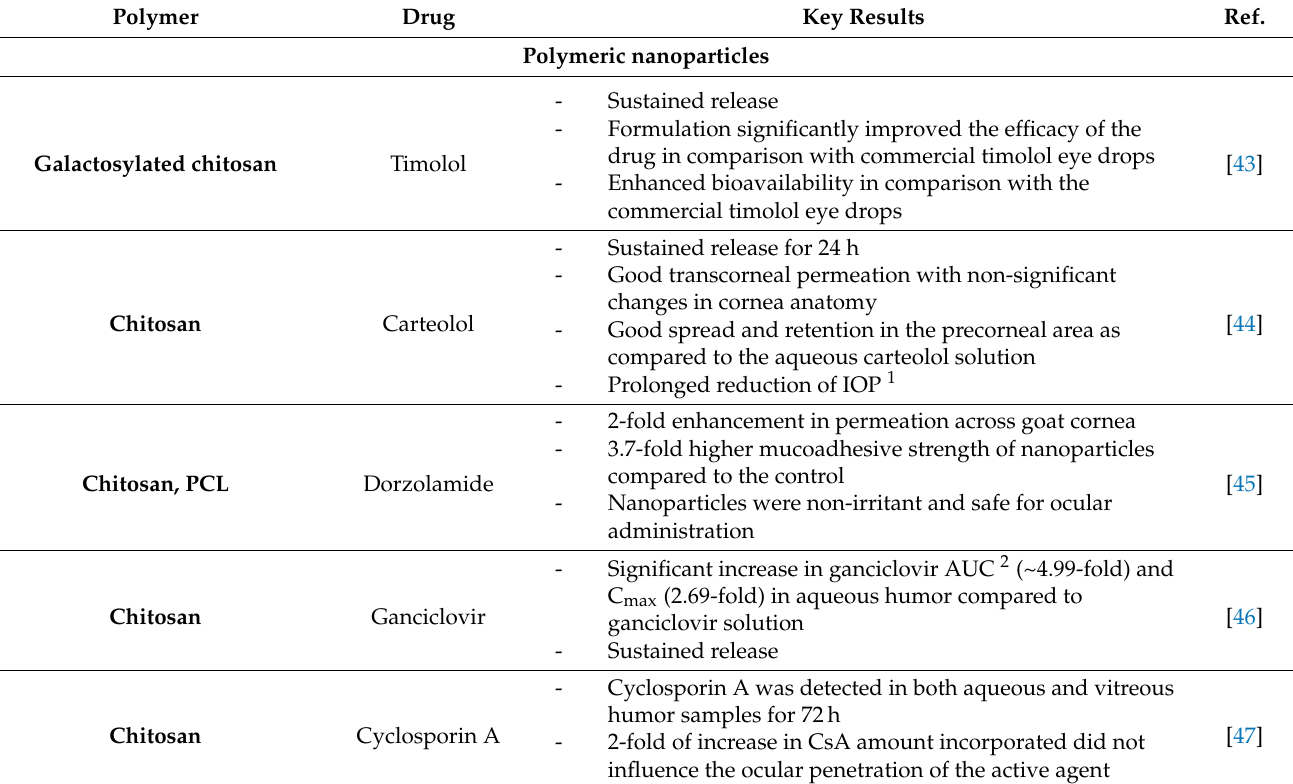
Table 1. Polymer drug delivery systems target the anterior segment of the eye. Polymer Drug Key Results